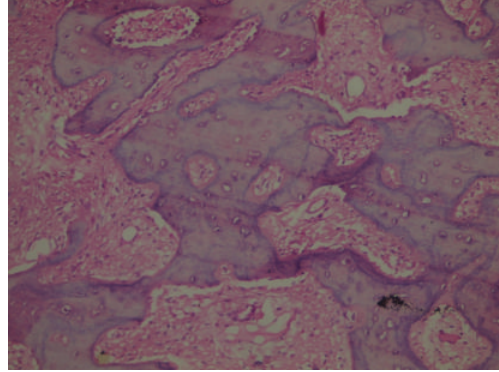
Figure 5: A photomicrograph showing trabeculae with presence of osteocytes and absence of peripheral rimming of osteoblasts (H/E,